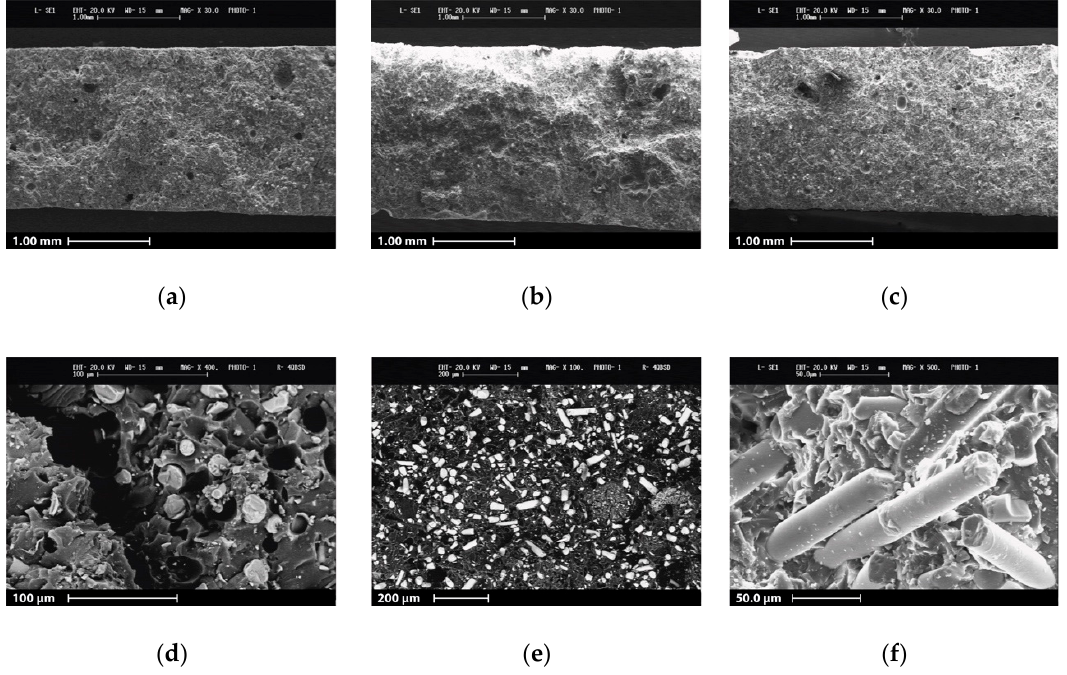
Figure 8. SEM micrographs of GAM fine 3D printed tensile specimen cross-section: a ) 55GAMF 250 µ m layer height; ( b ) 60GAMF 250 µ m layer height; ( c ) 60GAMF 500 µ m layer height; ( d ) inset image of 55GAMF 250 µ m layer height; ( e ) inset image of 60GAMF 250 µ m layer height; ( f ) inset image of 60GAMF 500 µ m layer height.